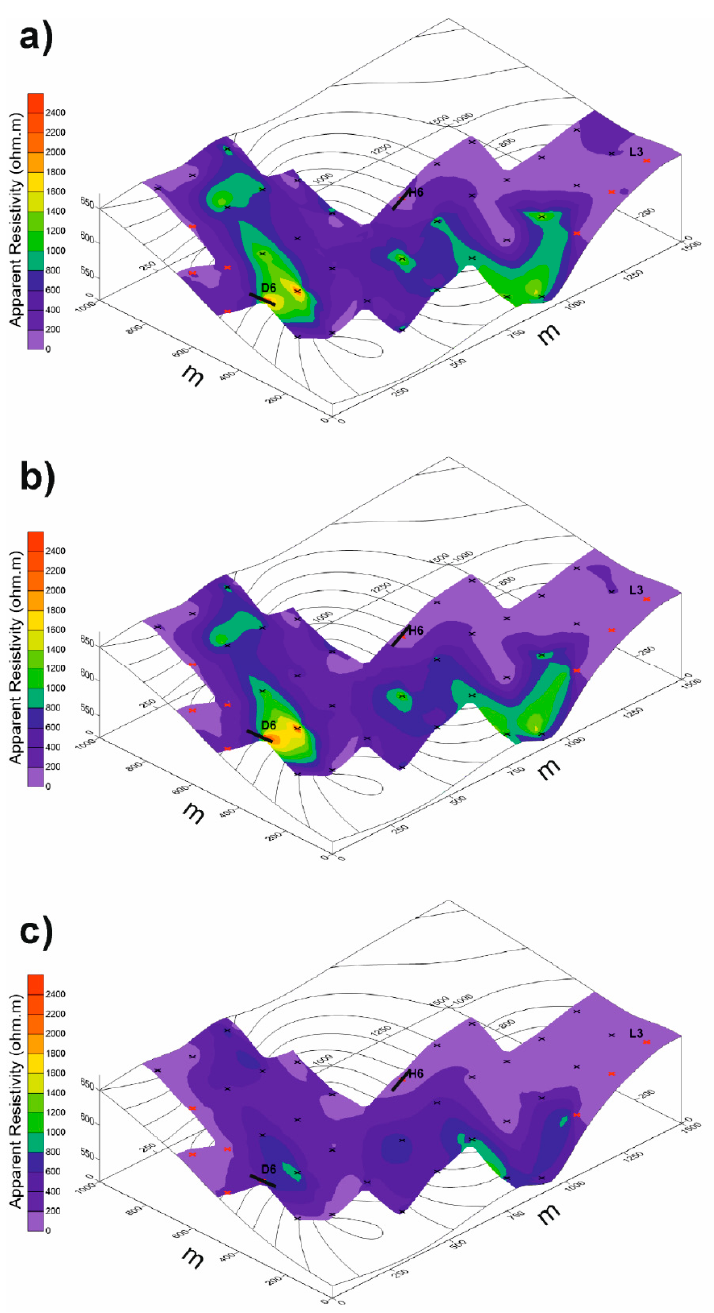
Figure 2. Apparent resistivity distribution from the electrical resistivity tomography (ERT) dataset on the study site in National Preserve (NP) Havešová ( a ) at 0.5 m depth, ( b ) at 1 m depth and ( c ) at 2 m depth. The plots with concentrated uprooted trees are marked by red crosses.